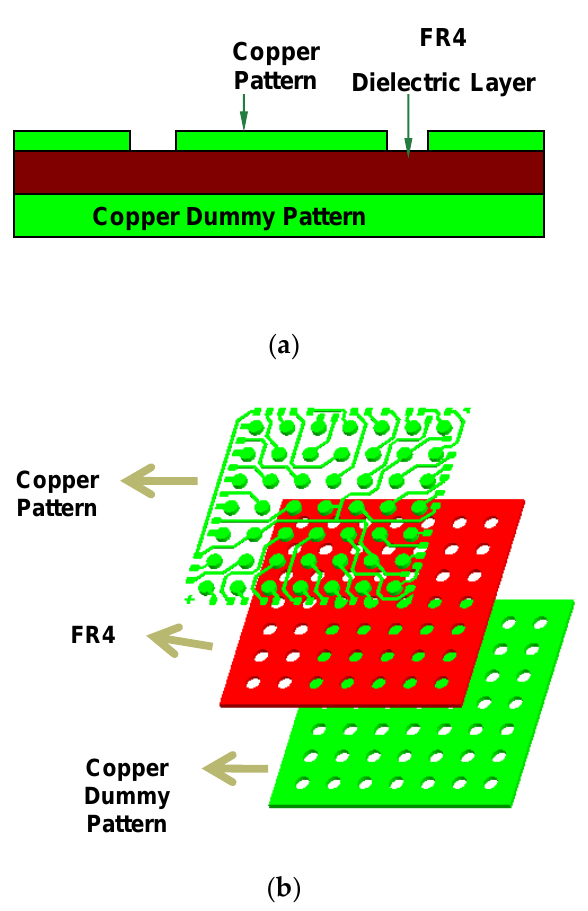
Figure 2. ( a ) Conceptual structure of PWB ( b ) construction of the three-dimensional MCAD model.